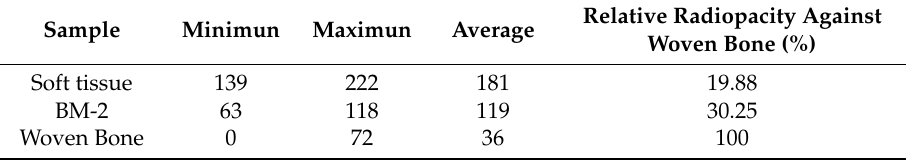
Table 3. Grayscale bit values from the analysis of radiopaque images.